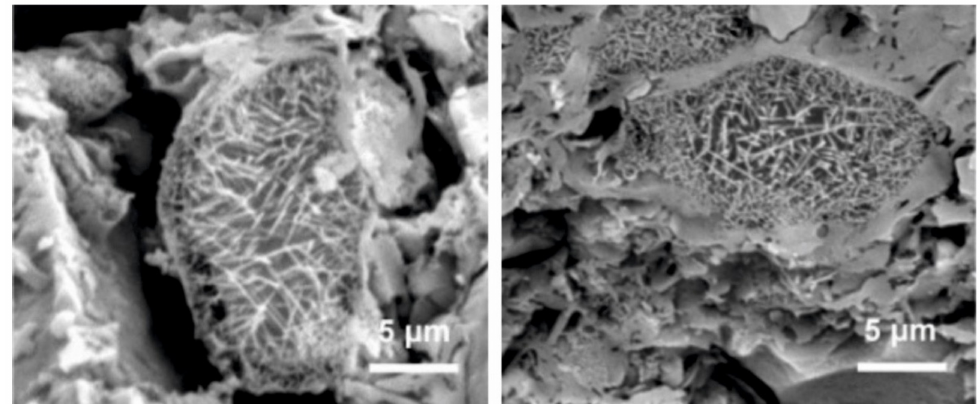
Figure 10. SEM photographs of HF-etched fracture surfaces of fired samples prepared from agate scraps